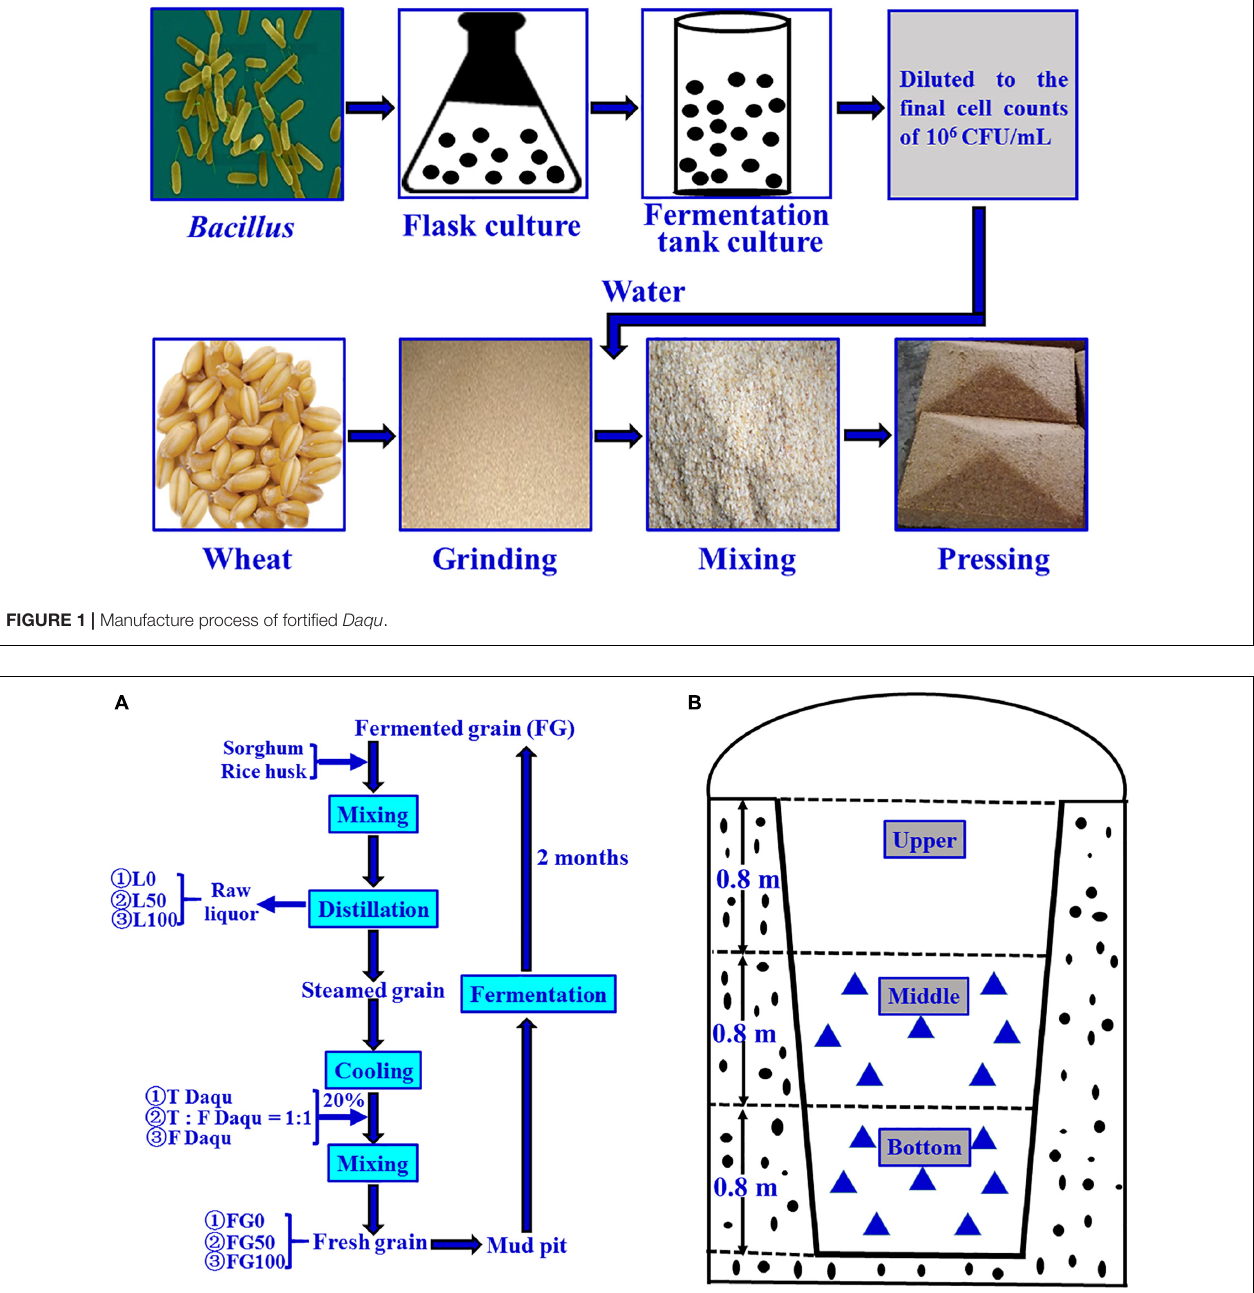
FIGURE 2 | Schematic diagram of brewing process for Chinese strong-flavor liquor (A) and sampling method (B) . Different proportions (0, 50, and 100%) of fortified Daqu were mixed with steamed grains, and the corresponding fermented grains (FG) and liquors were obtained. Every FG sample ( (cid:78) ) was collected from seven different positions (100 g FG at each position), and mixed well as one